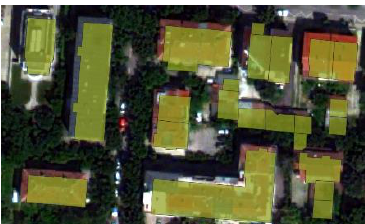
Figure 3. Shift misalignment of cadastral footprint and